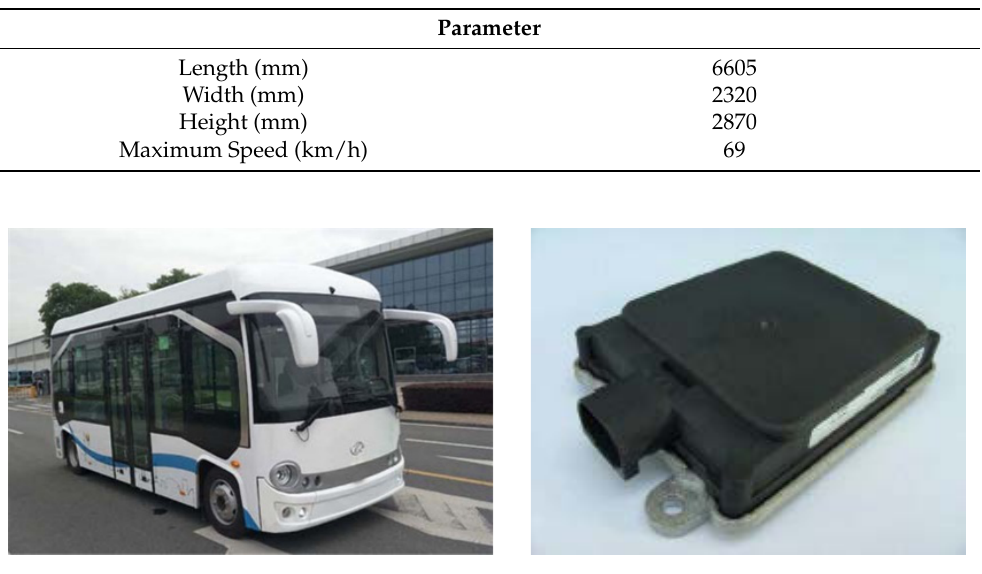
Figure 3. The bus and the millimeter-wave radar. Table 2. Electric bus parameter configuration